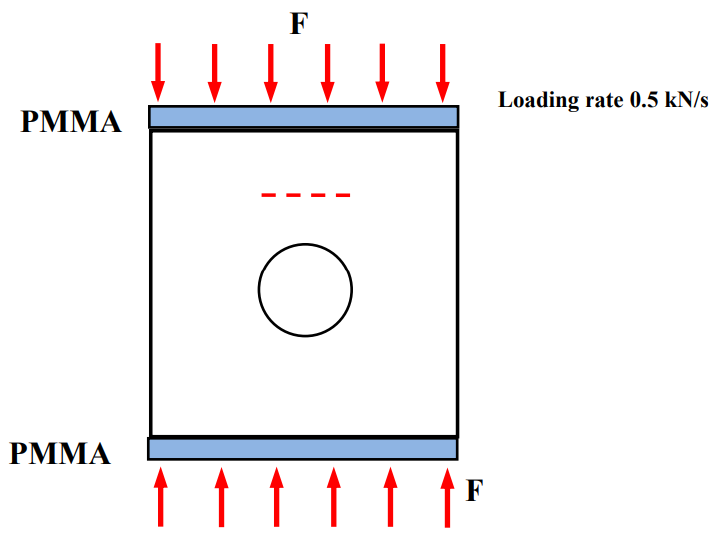
Figure 3. Uniaxial compression loading mode. The arrangement of orthogonal plane-polarized light field is shown in Figure 4.